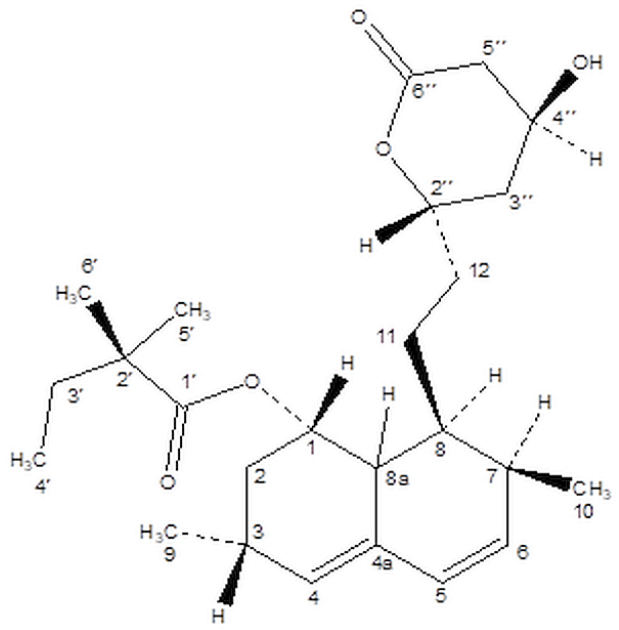
FIGURE 1 - Molecular structure of simvastatin (SVT) or 8 - [2 - (4-hydroxy-6-oxo-oxan-2-yl) ethyl] - 3, 7-dimethyl-1, 2, 3, 7, 8, 8a - hexa hydronaphthalene-1-yl] -2, 2 - dimethylbutanoate (IUPAC) [(1S,3R,7S,8S,8aR)-8-[2-[(2R,4R)-4-hydroxy- 6-oxooxan-2-yl] ethyl] -3,7-dimethyl-1,2,3,7,8,8a- hexahydronaphthalen-1-yl]